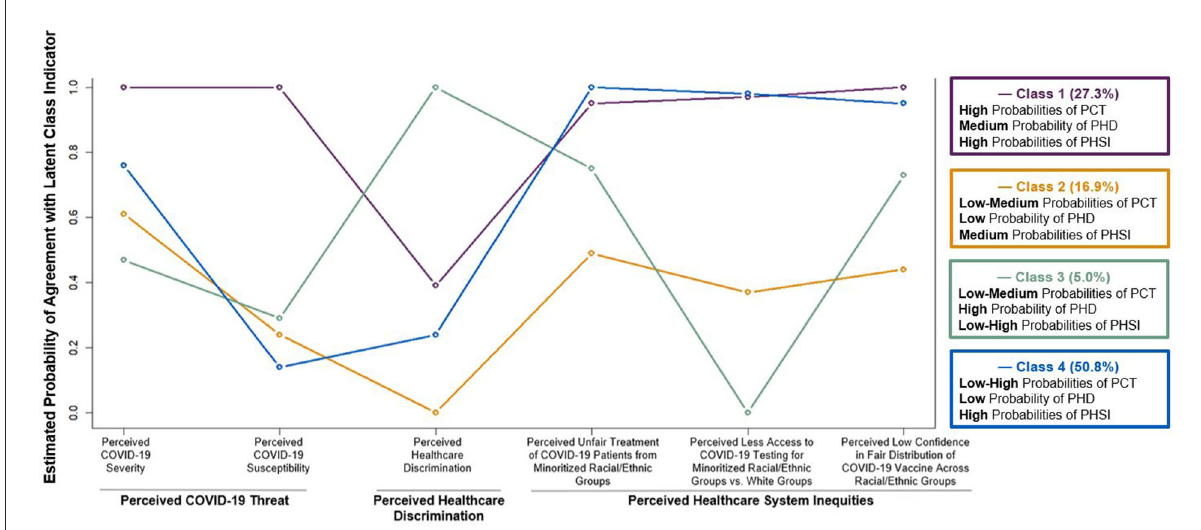
FIGURE1 Four-class solution of perceived COVID-19 threat (PCT), perceived healthcare discrimination (PHD), and perceived healthcare system inequities (PHSI). Estimated probabilities of selecting 1 vs. 0 for each dichotomously coded latent class indicator. The classes were labeled using the estimated probabilities of perceived COVID-19 threat, perceived healthcare discrimination, and perceived healthcare system inequities which were categorized as low: < 33%, medium: 33–66%, high: >